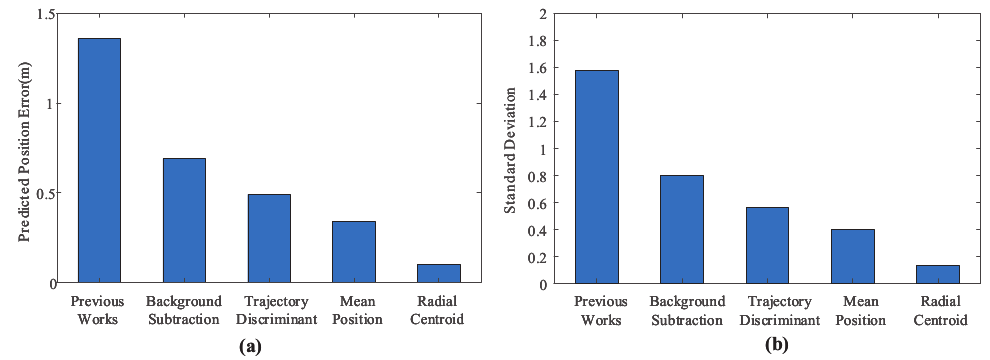
Figure 11. The mean and variance of prediction results for each improved method increased sequentially. ( a ) mean of prediction results; ( b ) variance of prediction results.